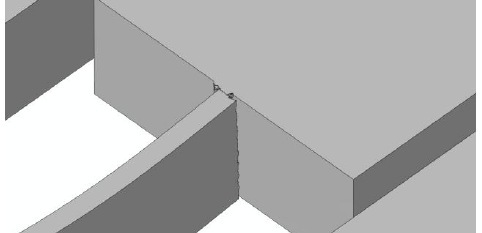
Figure 14. Failure mechanism induced by the tension-dominated loading (side-B